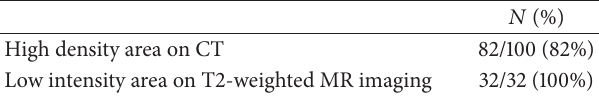
Table 2: CT and MR imaging findings.